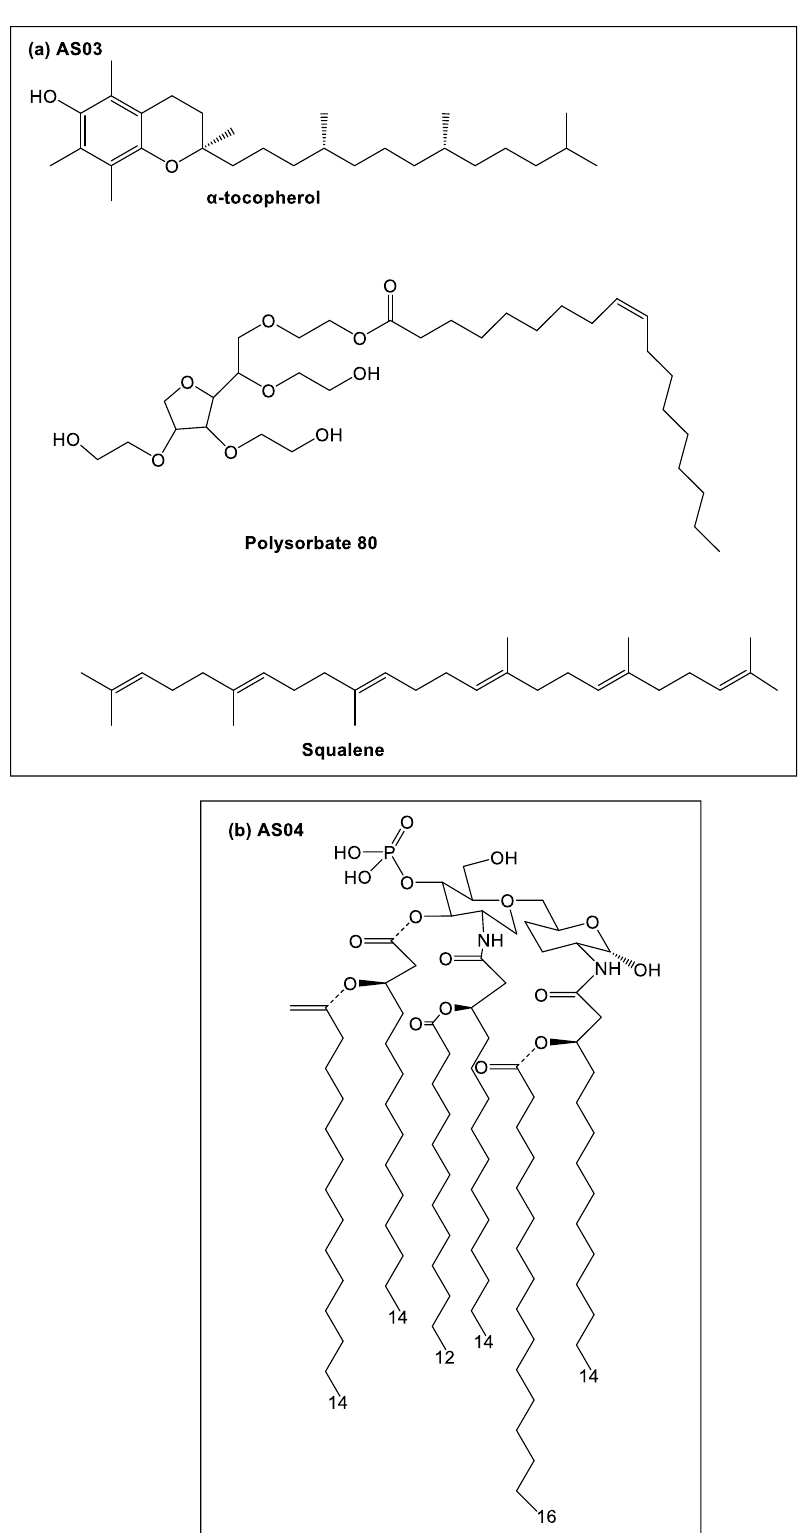
Figure 11. ( a ) Components of adjuvant system AS03 (assembled from squalene, polysorbate 80 and α -tocopherola [a type of vitamin E]). ( b ) MPL structure of adjuvant system AS04 as a TLR4 agonist which is mixed with alum.